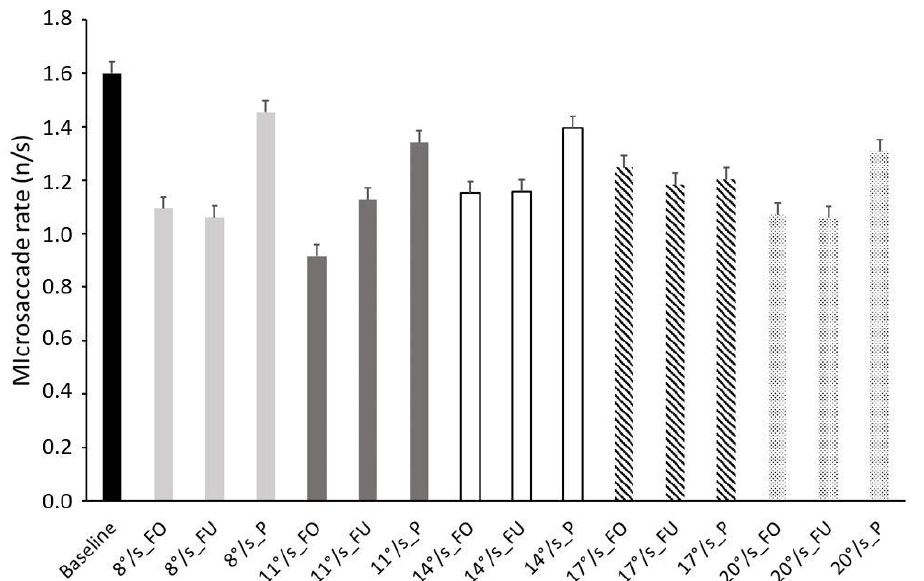
11 ◦ /s FO vs. 14 ◦ /s P, p = 0.039. Figure 4 shows that the stimulation of the peripheral retina evoked a higher microsaccade rate.